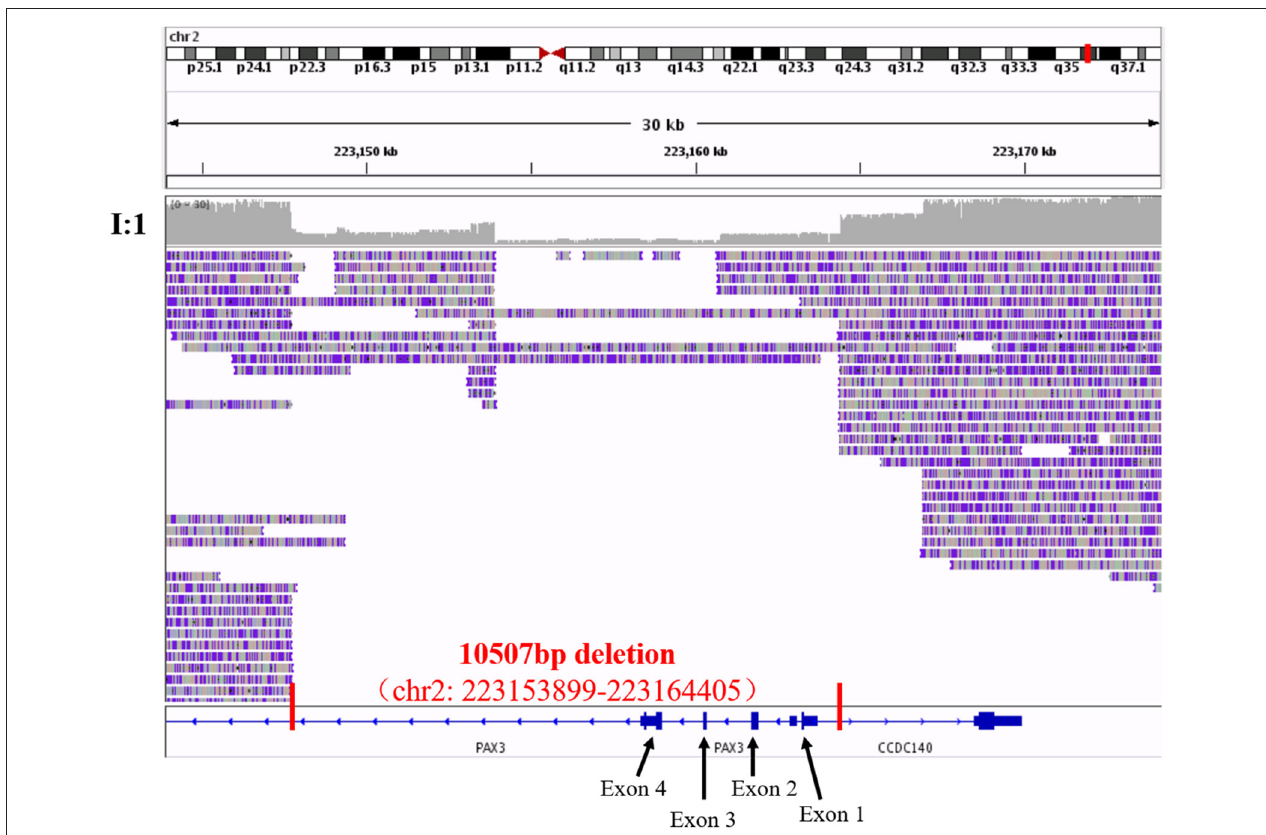
FIGURE 3 | The visualization of third-generation sequencing result of Chr2: 223143899-223174405 in I:1 by IGV software. Red vertical lines cut out the region of the structural variant, and red words exhibited the details of this structural variant. Black arrows and words point out the exons of PAX3 in the region.